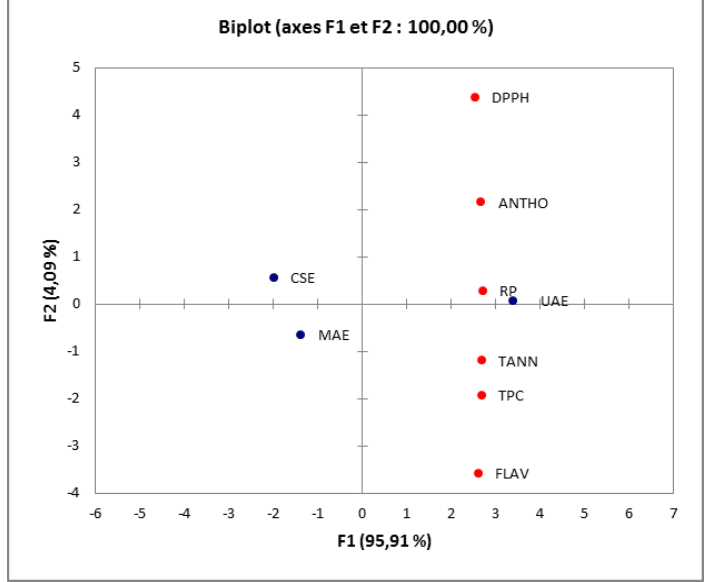
Figure 2. Principal component analysis of phenolic compounds for M. communis pericarp with UAE, MAE and CSE. FLAV, flavonoids; ANTHO, anthocyanins; TANN, tannins.